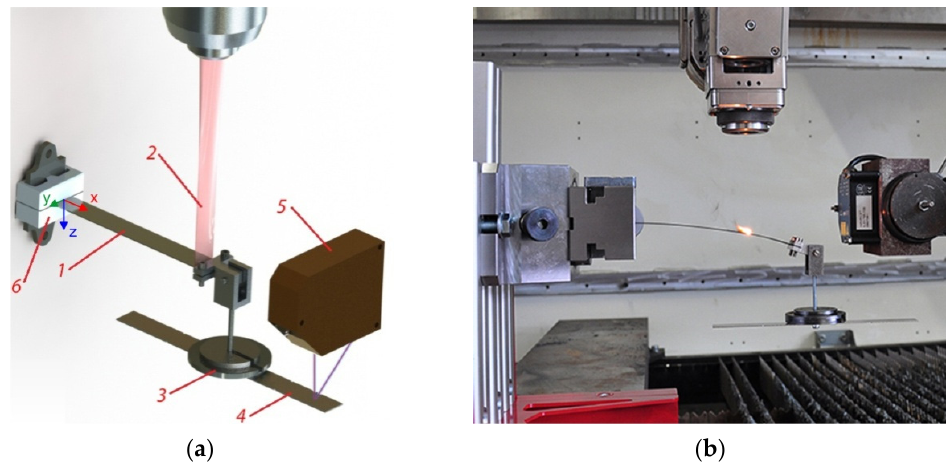
Figure 1. Experimental setup: ( a ) a scheme (1–specimen, 2–laser beam, 3–weights, 4–auxiliary plate, 5–optical displacement sensor, 6–fixture), ( b ) a photograph. Table 1. Chemical composition of Inconel 718 sheet (wt%).